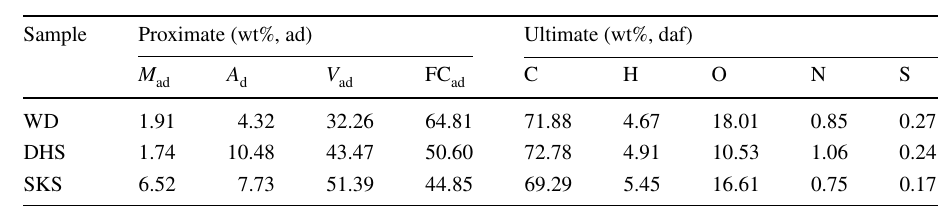
Table 1 Proximate and ultimate values of coal